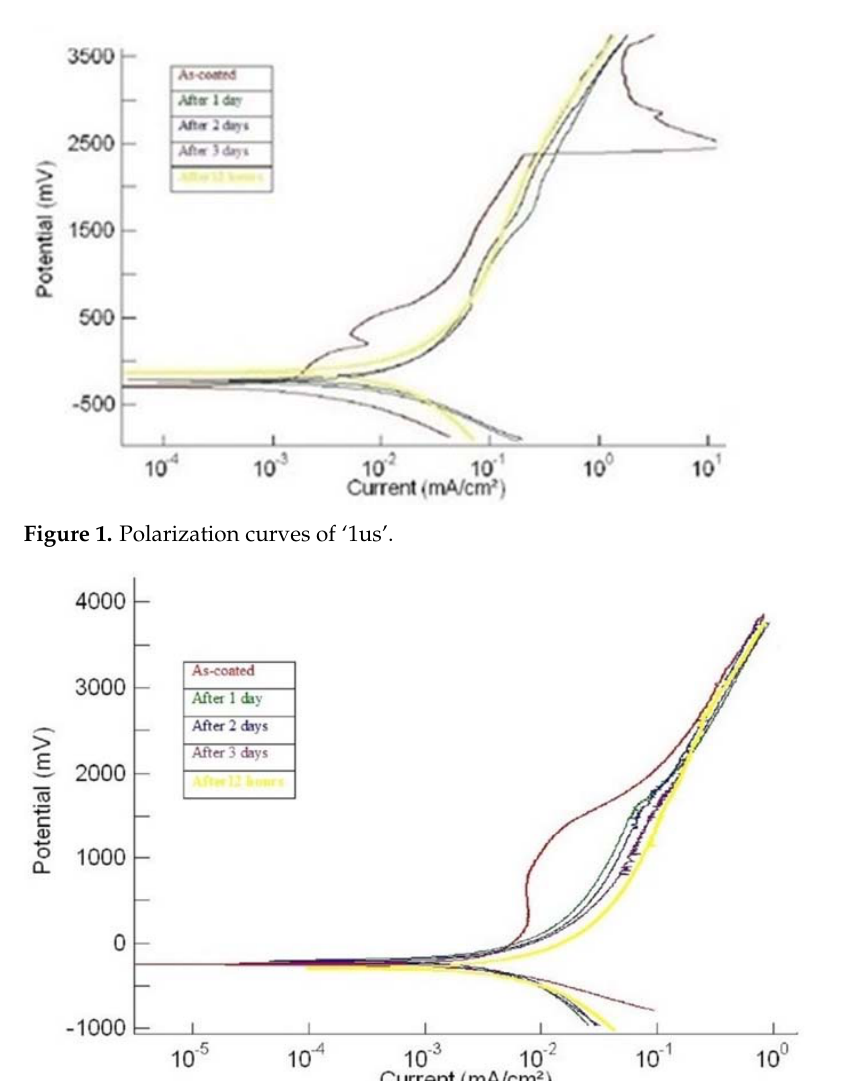
Figure 2. Polarization curves of ‘2hcd’.